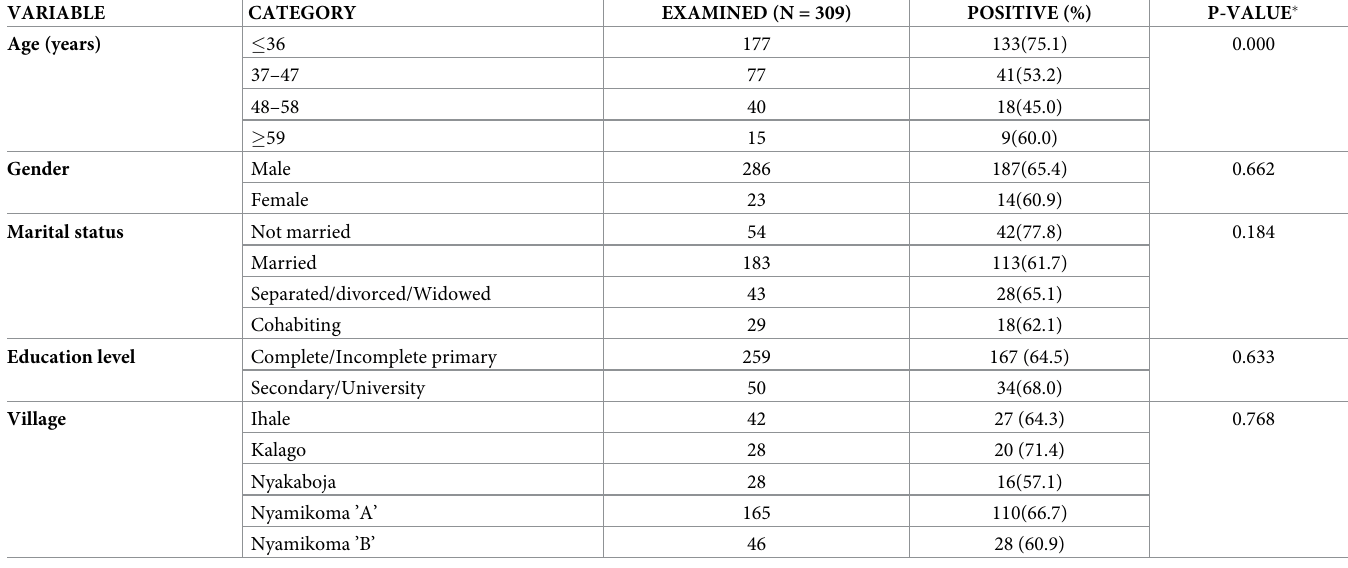
Table 2. Prevalence of S . mansoni infection in relation to demographic characteristics.